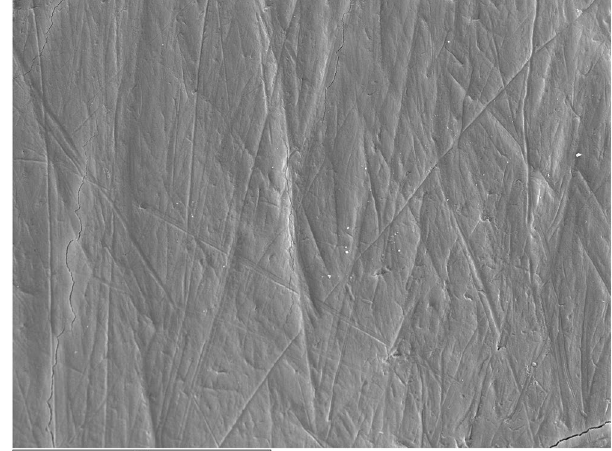
Figure 1. Group 1: Intact enamel. SEM micrograph (x1000).